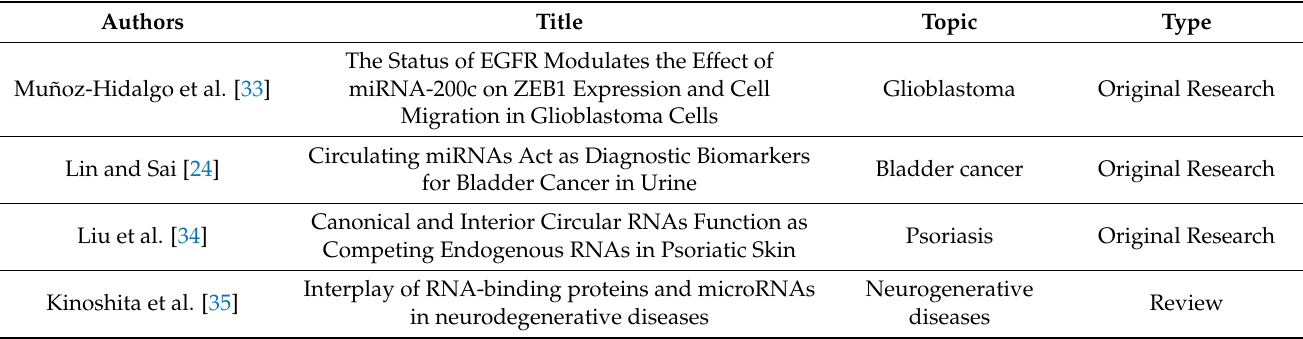
Table 1. Contributors to the Special